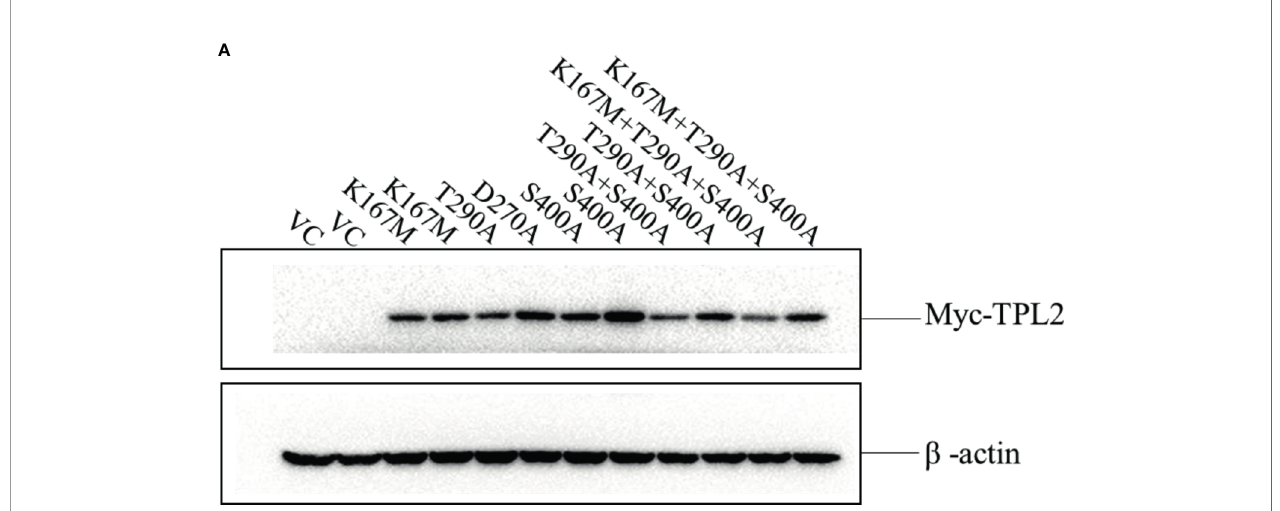
FIGURE 6 | (A) HEK293T cells were transfected with TPL2 functional site mutant plasmids. Vector plasmids (pCMV-3N-Myc) were used as vector control (VC). Except for plasmids of T290A and D270A, the others occupied two